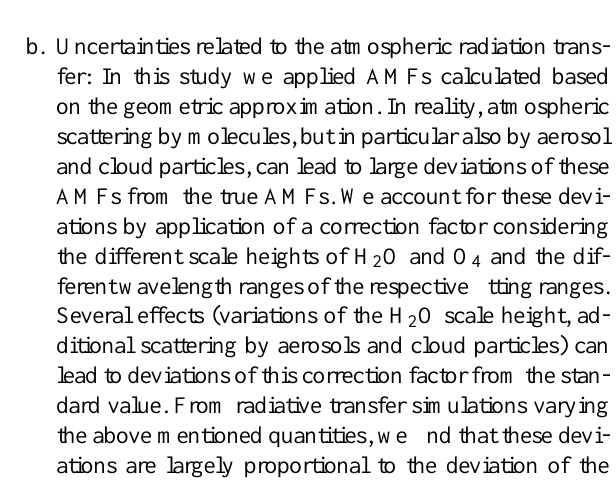
Fig. 9 Cloud classification scheme used in this study. Fig. 9. Cloud classification scheme used in this